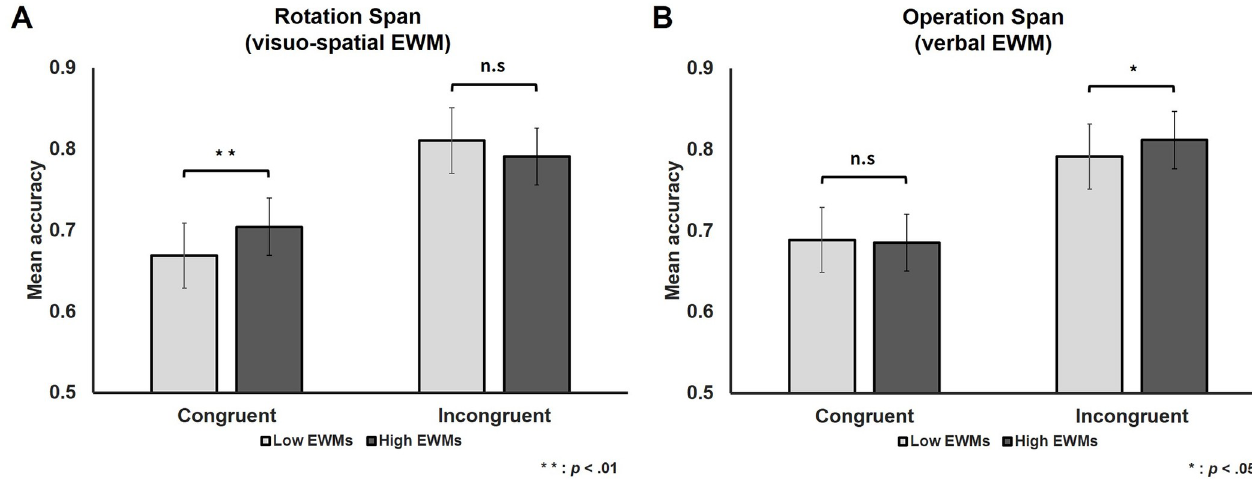
Fig 4. Results of ANCOVA on Numerosity Comparison accuracy using (A) visuo-spatial and (B) verbal EWM groups as within-trial factors and Congruency as between-trial factors (along with IDS ratio and RT as covariates of non-interest). There was a significant two-way interaction between Congruency and visuo-spatial EWM Group (A). There was a no significant two-way interaction between Congruency and verbal EWM Group (B). Error bars represent standard errors of the